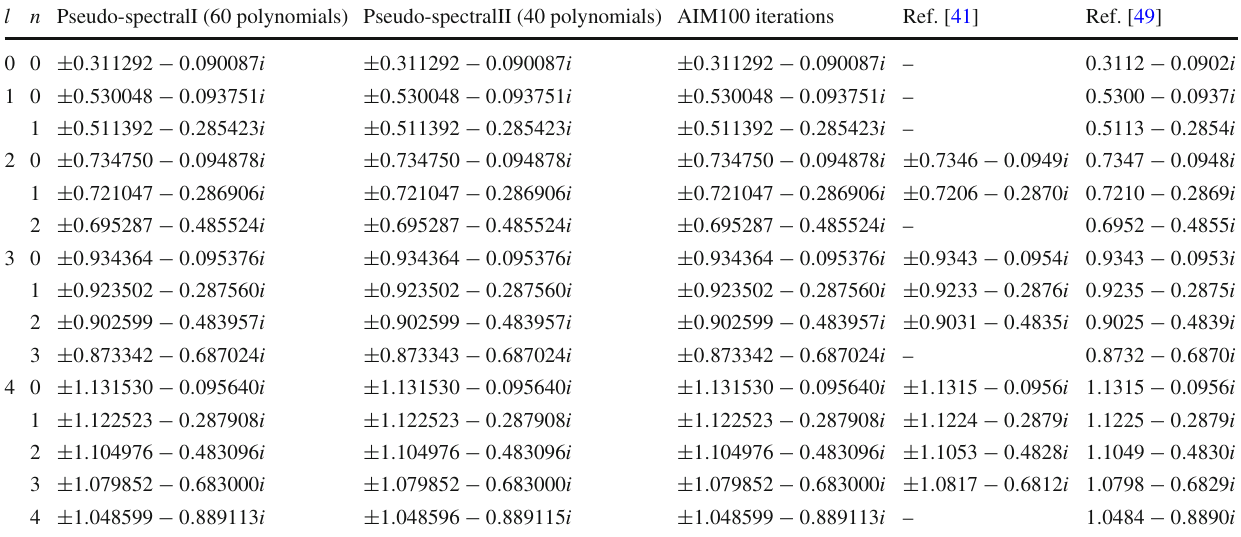
Table 6 Quasinormal frequencies of spin 3 / 2 perturbations normalized by the mass ( M ω) compared against the results of Refs. [41,49] l n Pseudo-spectralI (60 polynomials) Pseudo-spectralII (40 polynomials) AIM100 iterations